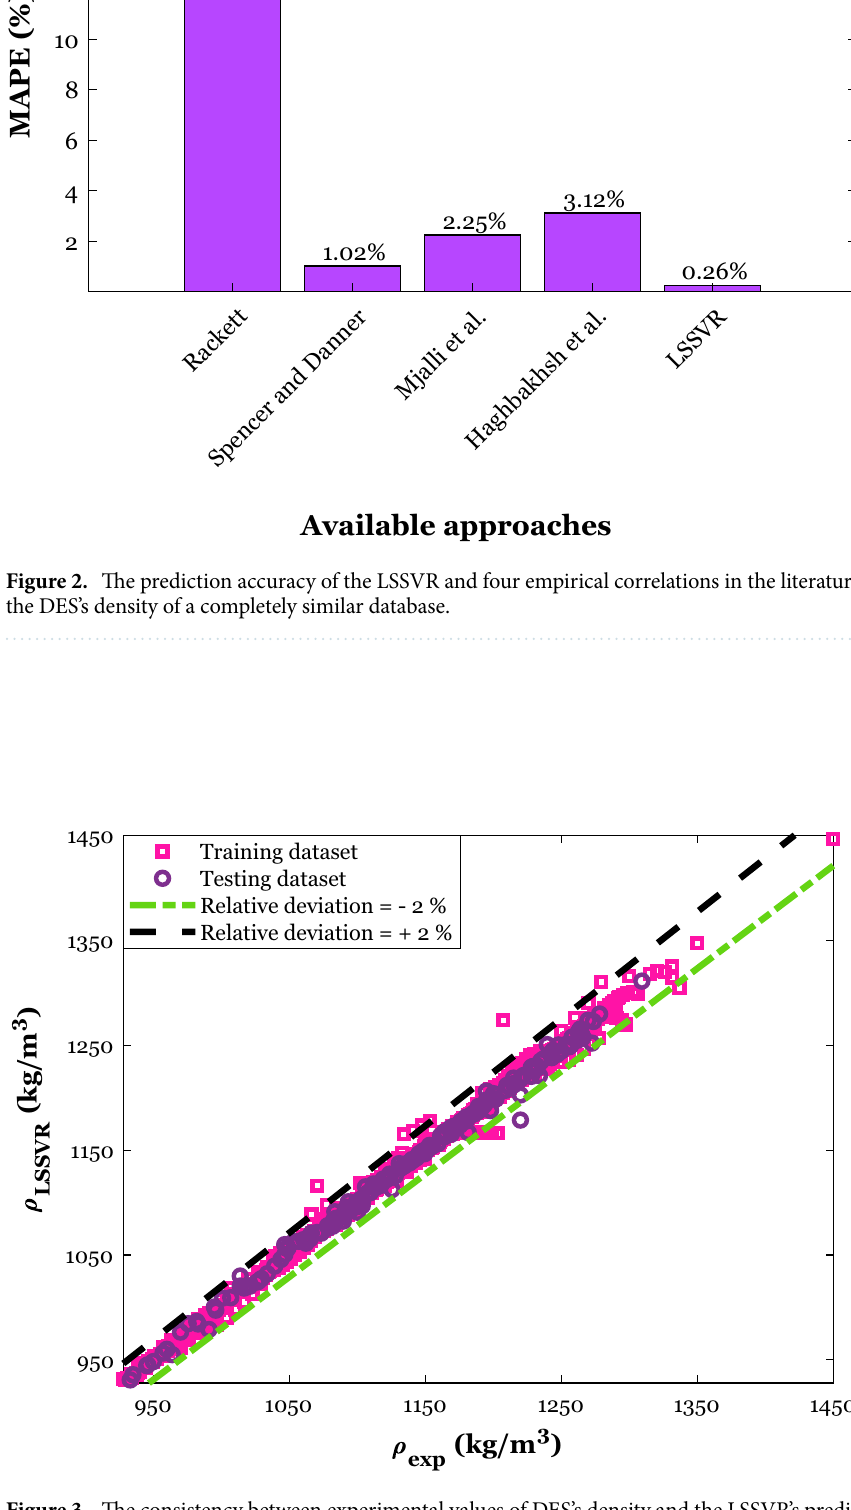
Figure 3. The consistency between experimental values of DES’s density and the LSSVR’s